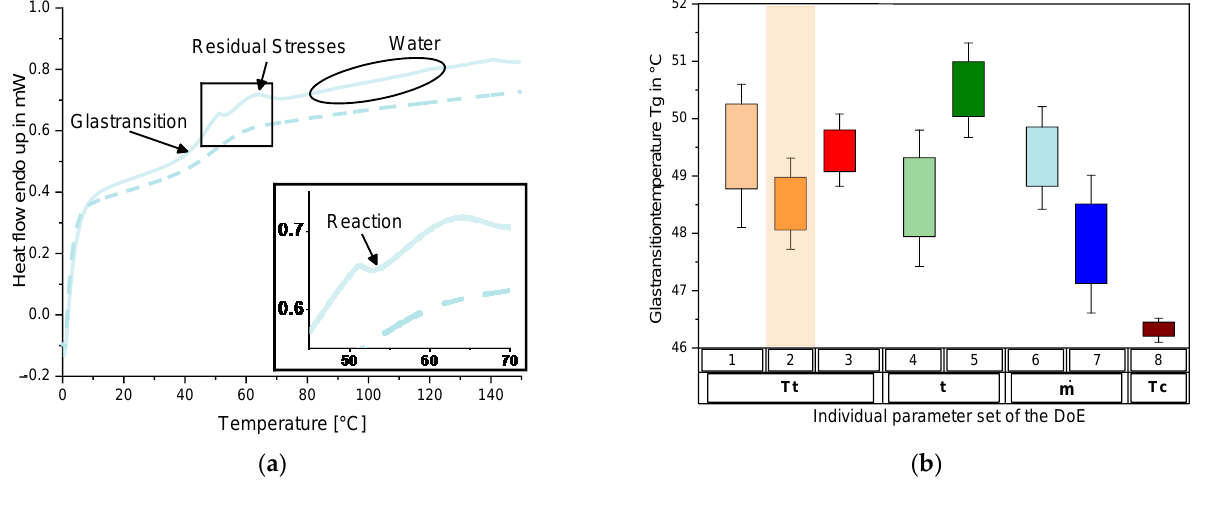
Figure 5. DSC Analysis; ( a ) temperature dependent heat flow (parameter set 6) for the first heat cycle (continuous line) and the second heat cycle (dashed line); ( b ) glass transition temperature for all processes in the second heat cycle (reference in orange).